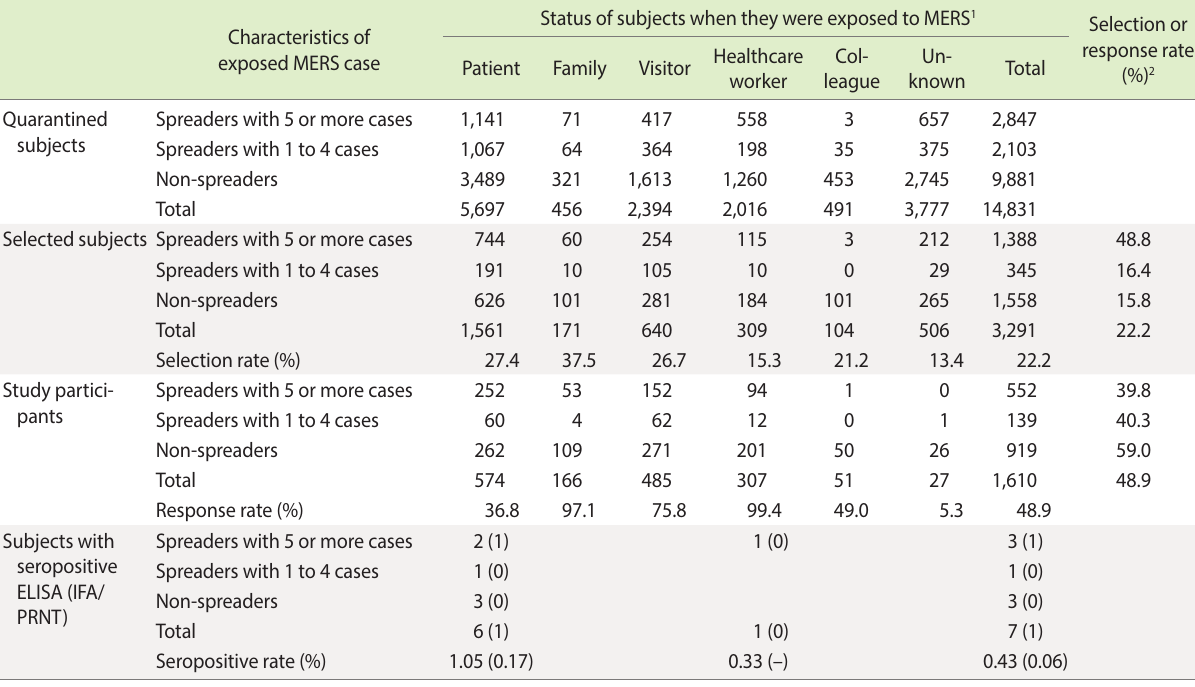
Table 1. Study subjects and seropositive participants by characteristics of the MERS case they were exposed to, and status of subjects upon MERS exposure in the 2015 Korean